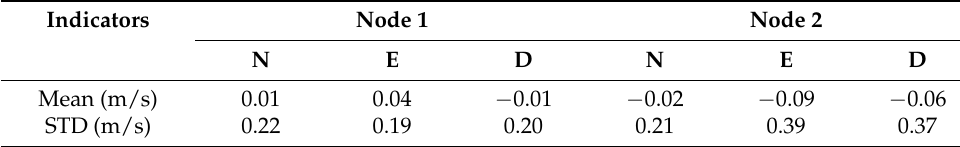
Table 6. Statistics of joint navigation positioning velocity error without an